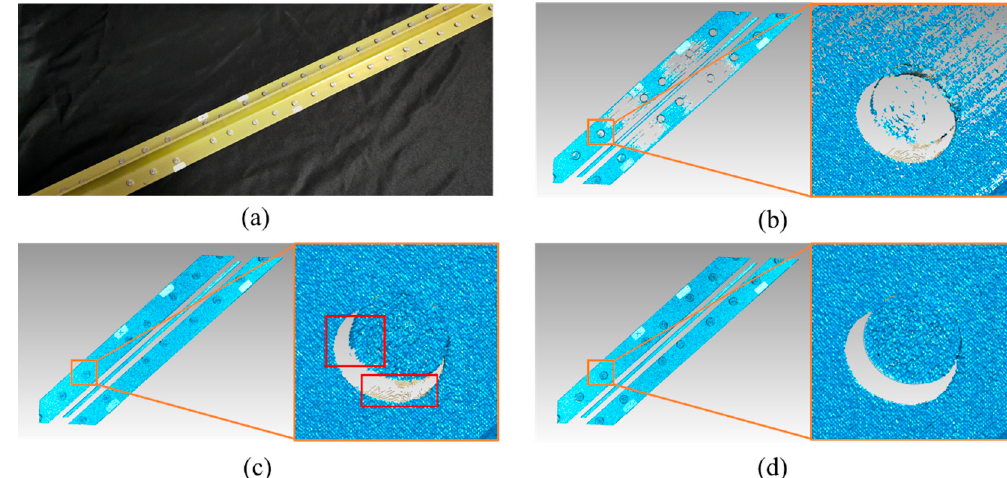
Figure 6. Measurement results of the riveted frame. ( a ) is the sample of the riveted workpiece, which is a riveted aluminum frame. ( b ) is the measurement result under the traditional FPP method with a single intensity setting. ( c ) is the measurement result of HDR FPP without texture constraint, where the red boxes indicate the missing points and artifacts. ( d ) is the measurement result under our proposed method.